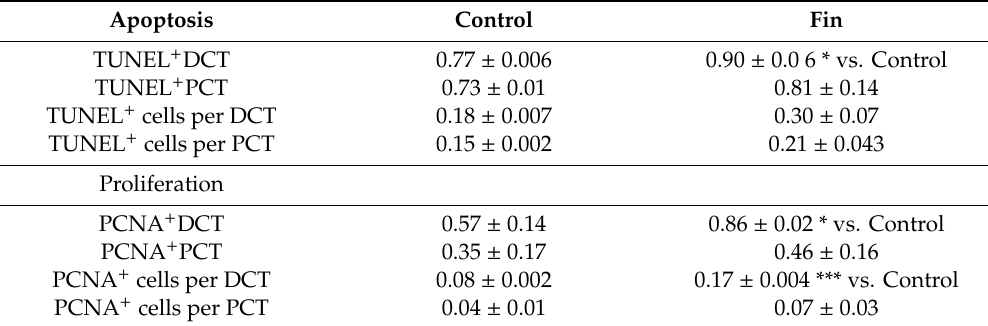
Table 4. The percentage of TUNEL-positive or PCNA-positive tubules (DCT or PCT) [tubule was considered as positive if the presence of a color reaction in at least one nucleus per tubule was detected] and the number of TUNEL-positive or PCNA-positive cells per one tubule (DCT or PCT) in control and finasteride-treated rats.